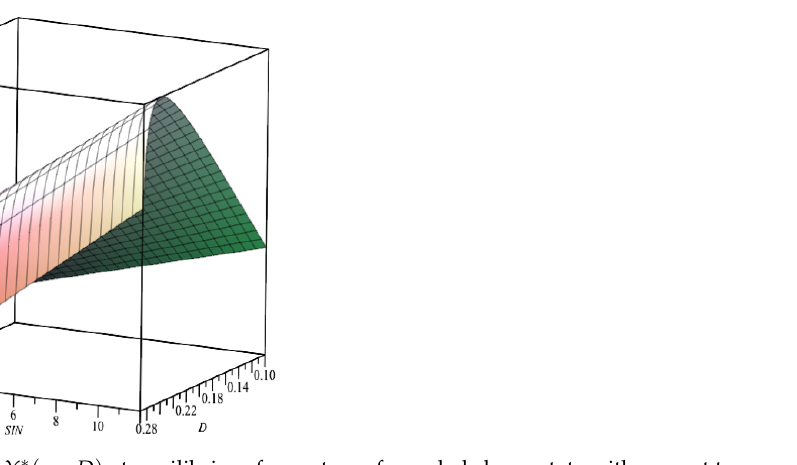
Figure 9. Yield Y ∗ ( s in , D ) at equilibrium for system of coupled chemostats with respect to s in and D . Parameters set: µ = 0.3 h − 1 , k = 0.2 g · L − 1 and s in = 12 g · L − 1